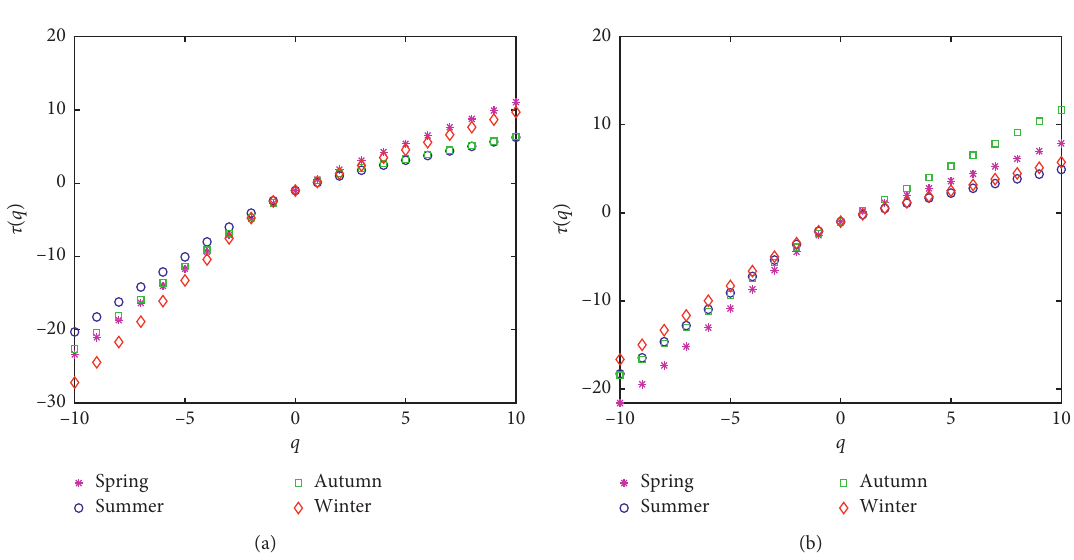
Figure 4: Renyi exponent of (a) PM